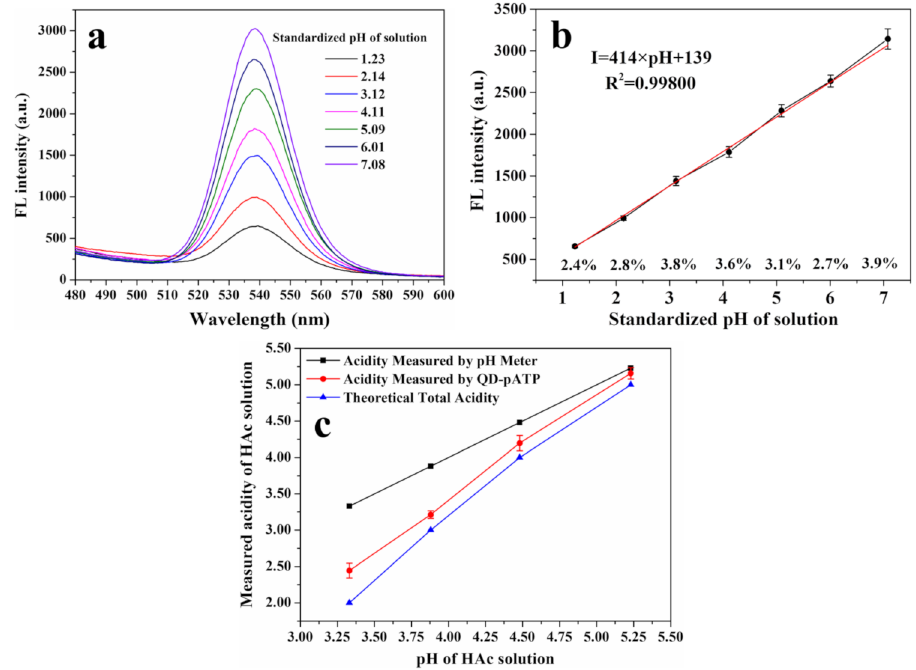
Figure 5. ( a ) The response of the fluorescence spectra of CdZnSeS-pATP QDs in aqueous solutions with standardized pH values. ( b ) The linear dependency between the fluorescence intensity at maxi- mum emission 537 nm and pH. The error bars represent the standard deviation of four measurements. The RSD of four measurements were marked at each pH. The red line represents the fitting curve of measured values. ( c ) The measured acidity of HAc solutions of 1.0 × 10 − 2 M, 1.0 × 10 − 3 M, 1.0 × 10 − 4 M and 1.0 × 10 − 5 M by pH meter and CdZnSeS-pATP QDs. The error bars represent the standard deviation of four measurements. (C QDs = 8.28 × 10 − 5 mg/mL, Water:DMSO = 150:1( V / V ), λ ex = 365